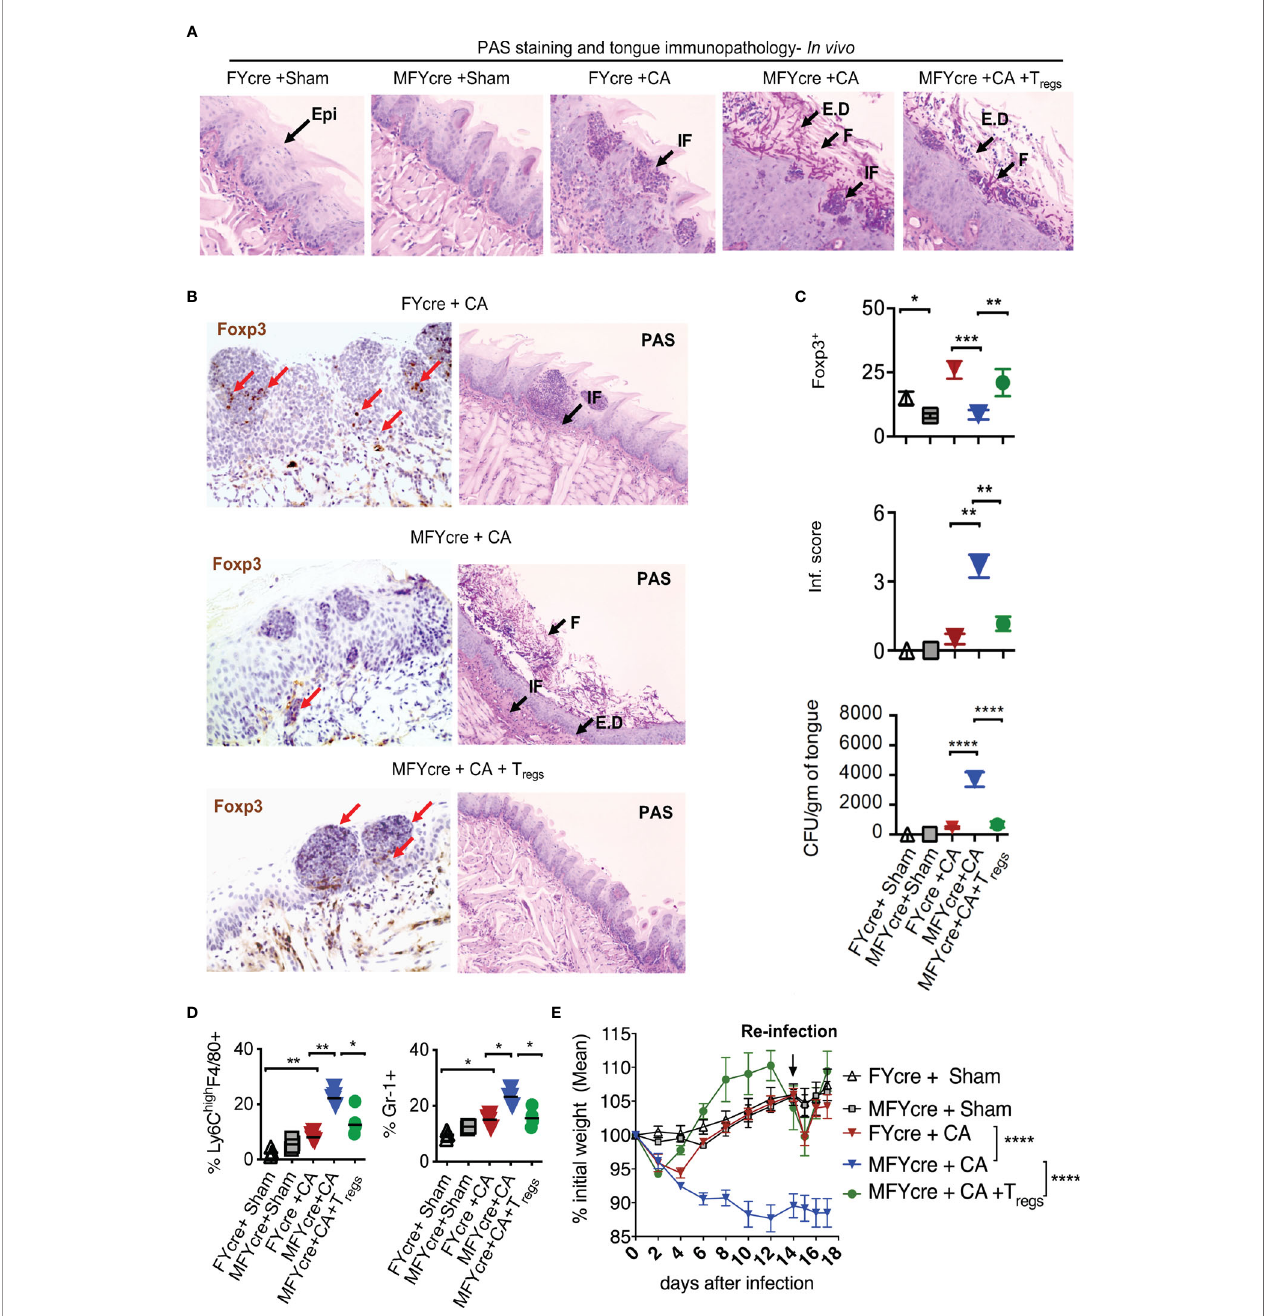
FIGURE 2 | T reg speci fi c deletion of MyD88 reduces results in impaired resistance to oropharyngeal candidiasis (OPC) in mice, and T reg reconstitution reduces fungal burden and immunopathology. FYcre and MFYcre mice were sublingually infected with CA or PBS (Sham) in vivo (n= 4-5/group). (MFYcre +CA + T regs ) group received 1 x 10 6 CD4 + CD25 + GFP + T regs from Foxp3-GFP reporter mice. (A) Periodic Acid Schiff ’ s (PAS) staining was done on tongue sections isolated from mice on day 7 after infection. (B) Foxp3 (left) and PAS (right) immunohistochemistry evaluation was performed on tongues derived from mice on day 7 and 18 after infection, respectively. Microscopic images of the slides viewed at 20X magni fi cation (Epi, epithelium; E.D, epithelial damage; F, fungus; IF, immune cell in fi ltration; Red arrows indicate some of the Foxp3 + cells). (C) Statistical analyses of # Foxp3 + (top) cells, in fl ammation score (middle) from 20X images of the tongues, and fungal burden (CFU/gm of tongue) (bottom panel) assessed in tongue lysates from mice on day 6 or 7 after infection (* P<0.05; Mann Whitney test). (D) MOILs were isolated on day-6 after infection and processed for fl ow cytometric staining of F4/80 and Ly6C (left, Figure S5B ) and Gr-1 (right, Figure S5C ). Data represent two experiments. (E) Mouse body weight was monitored every other day after infection until the day of sacri fi ce. The percent weight change in mice in all groups. Mean values ± SEM are plotted. (2 way ANOVA, multiple comparison; alpha= 0.05* signi fi cant). At least 3-5 independent experiments showed similar results. **P < 0.005, ***P< 0.0005, ****P <